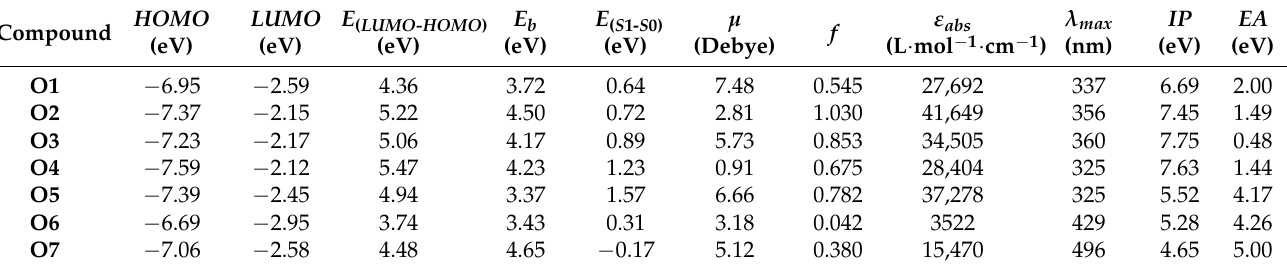
Table 1. Electron excitation parameters of each molecule.